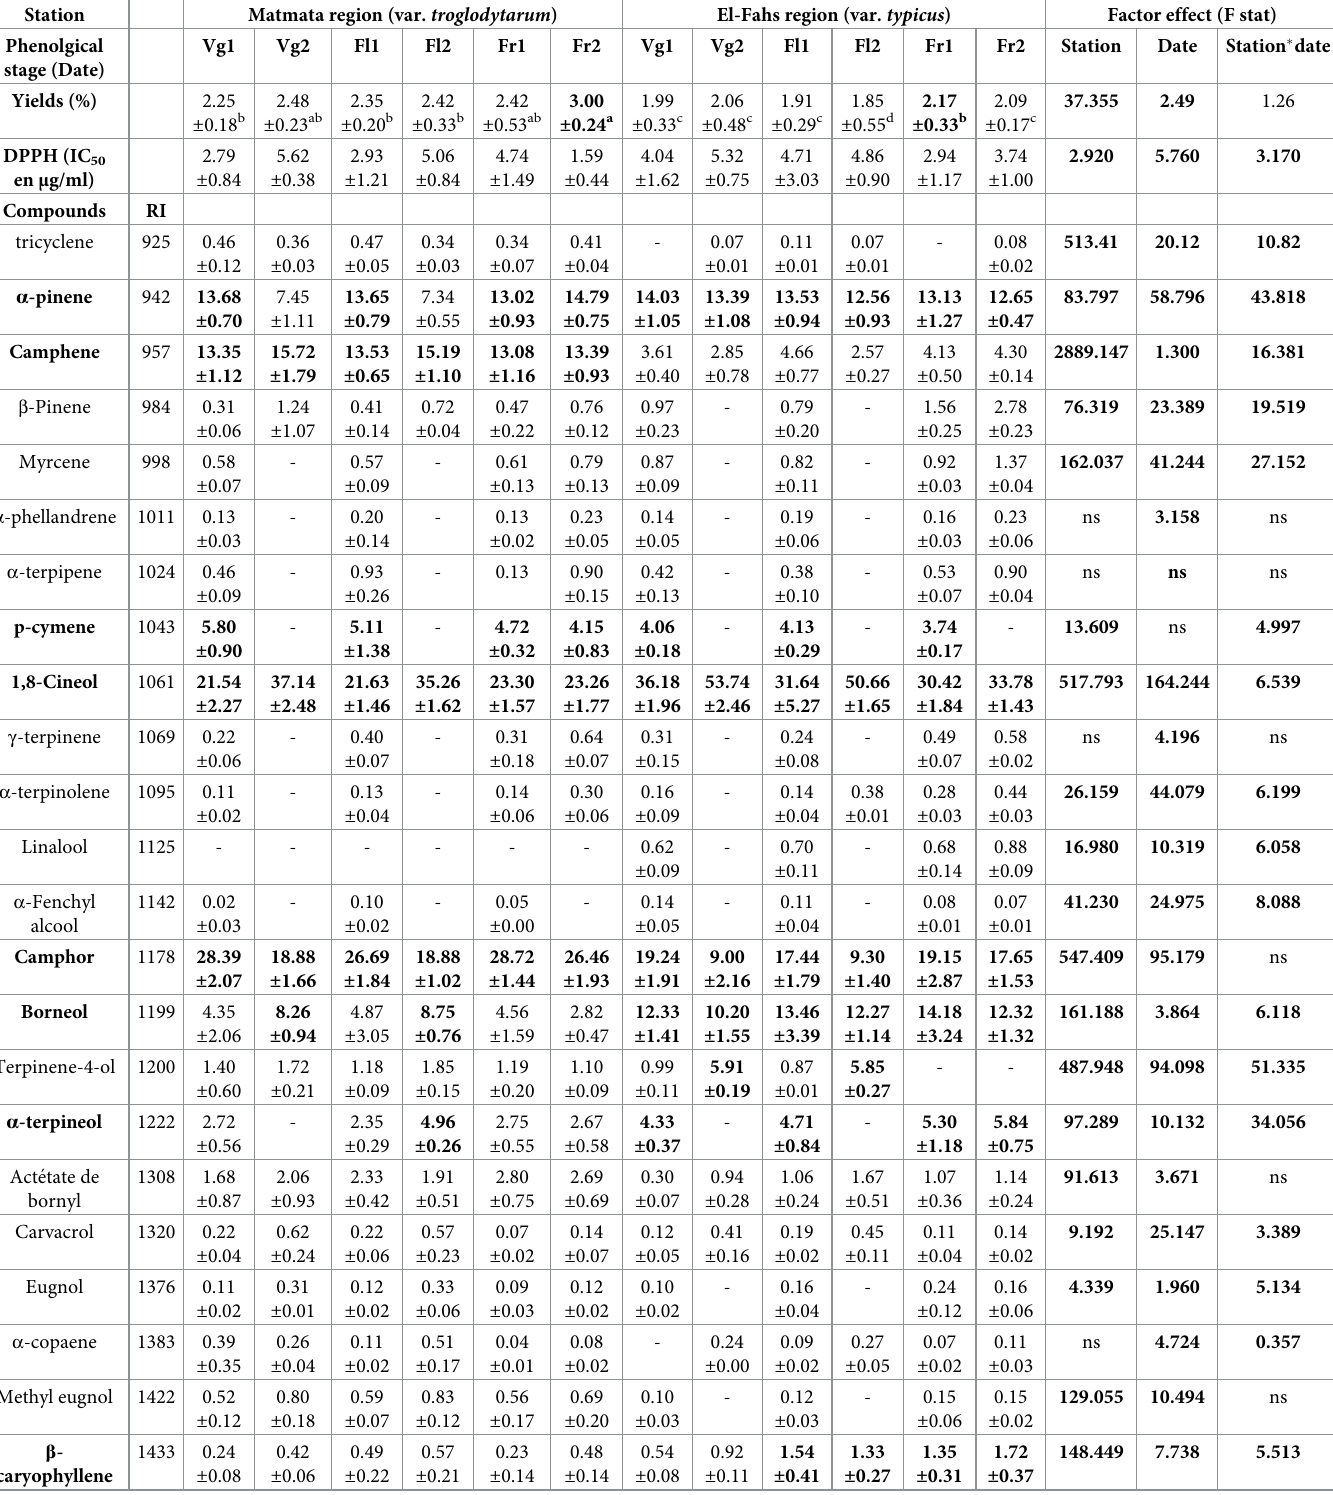
Table 2. Yield and chemical composition of the essential oils of Rosmarinus officinalis samples. Station Matmata region (var. troglodytarum ) El-Fahs region (var. typicus